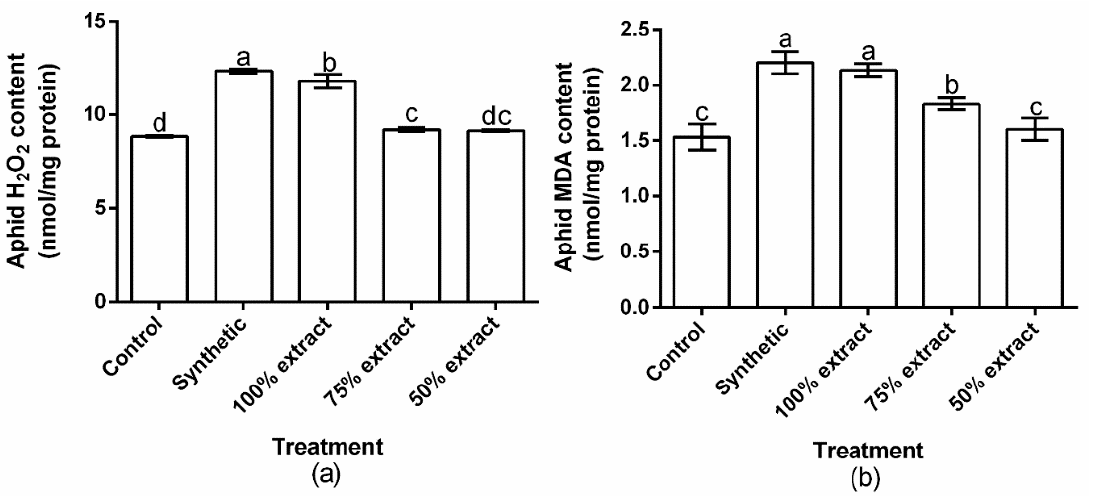
Figure 4. The effect of potato leaf extract on ( a ) aphid hydrogen peroxide content and ( b ) aphid malondialdehyde content. Data represent the mean ± standard deviation of three replicates. Lower- case letters indicate means that are significantly different according to the LSD test ( p < 0.05). Note: synthetic pesticide (recommended rate of Beta cypermethrin).